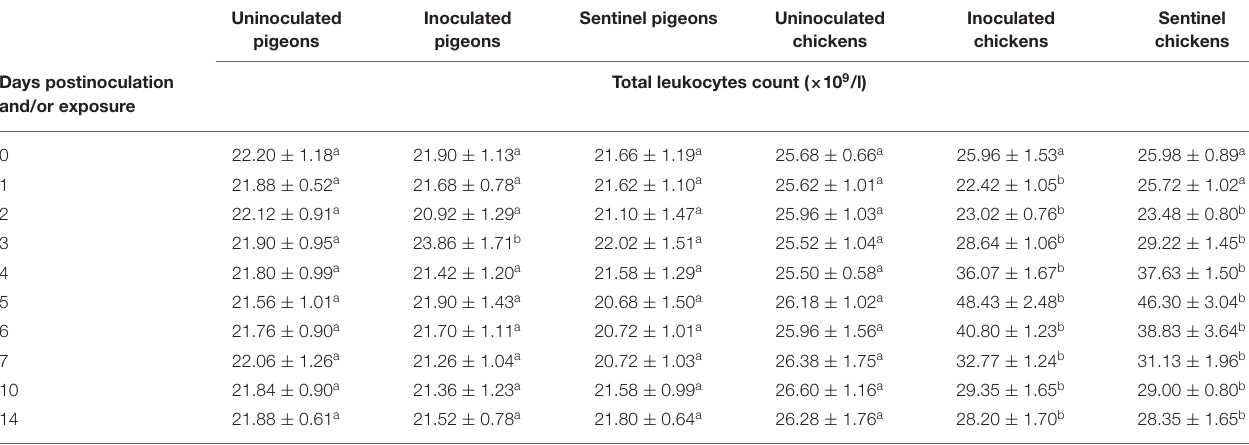
TABLE 4 | Mean total leukocyte count of pigeons and chickens following inoculation with and/or exposure to a very virulent infectious bursal disease virus.